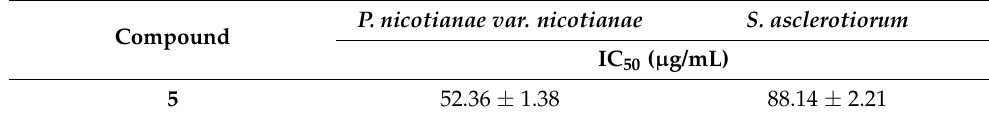
Table 5. Antifungal activity of compound 5 against plant pathogenic fungi.